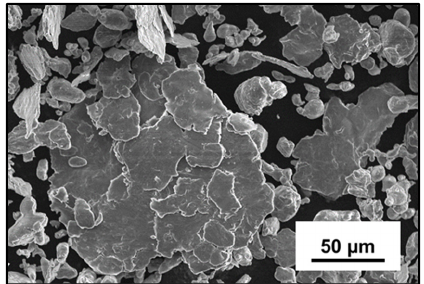
Figure 5. SEM micrograph showing agglomeration of individual sheared and fractured particles to form a larger particle for 4 h cryomilled Al-3Mg powder sample.